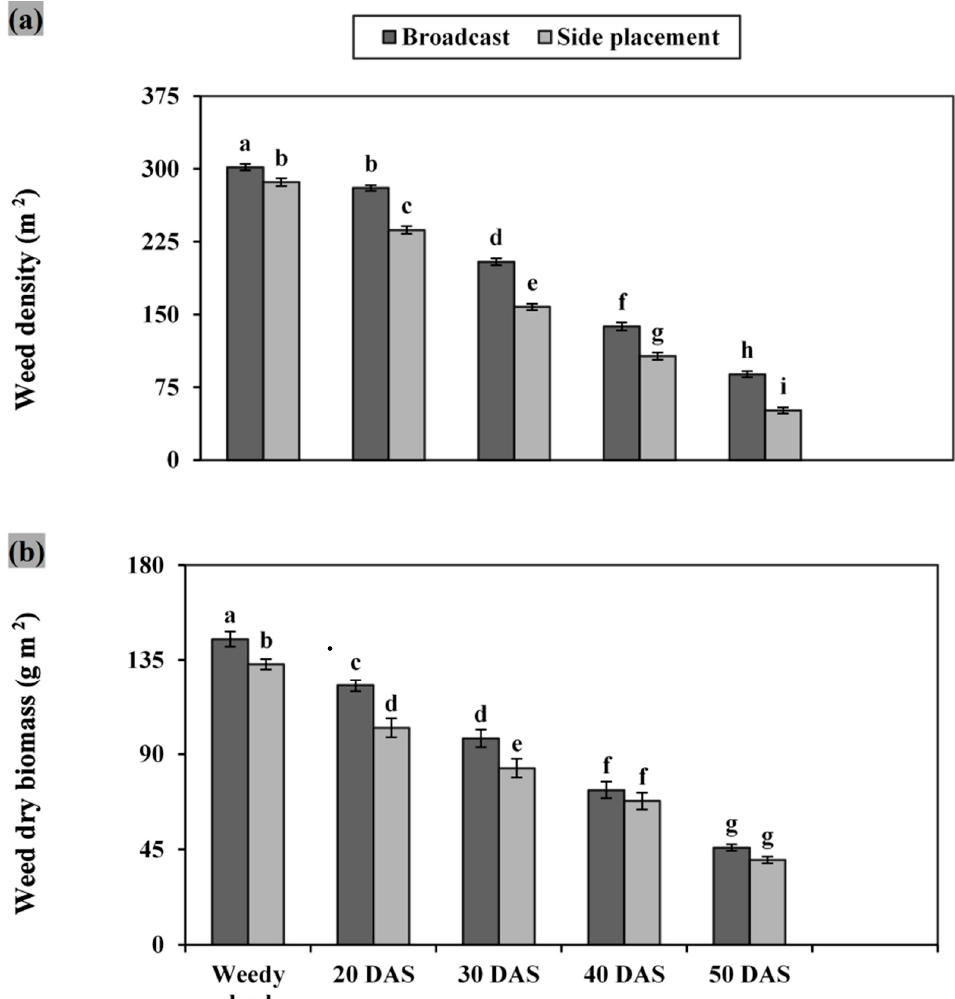
Figure 2. Effects of different weed-free periods on ( a ) weed density and ( b ) weed dry biomass in direct-seeded rice under different fertilizer application methods. Vertical bars above mean denote the standard error (±) of six replicates and letters depict significane at 5% probability level. Units on x -axis remain same for both a and b figures, (2 years mean data).